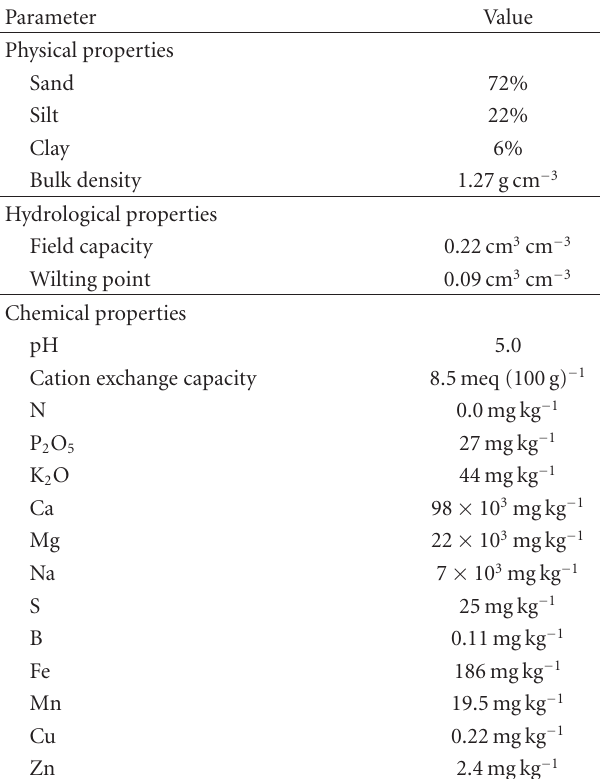
Table 2: Initial physical, hydrological, and chemical properties of the soil at the field station of Nova Scotia Wild Blueberry Research Institute, Debert, NS, Canada.